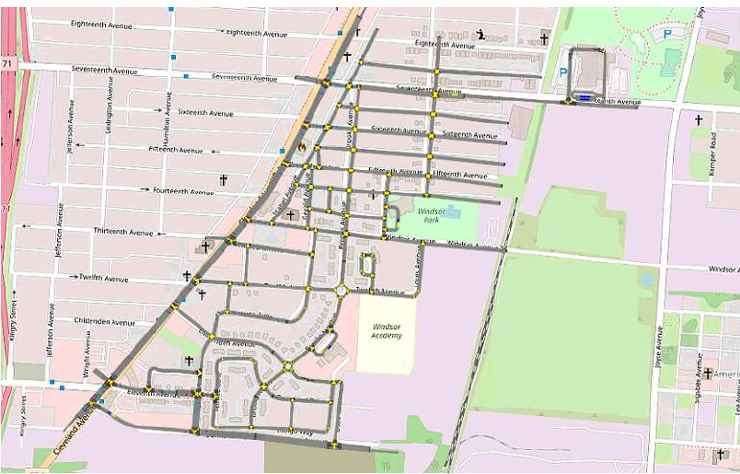
Figure 3. Simulated Area of Deployment.